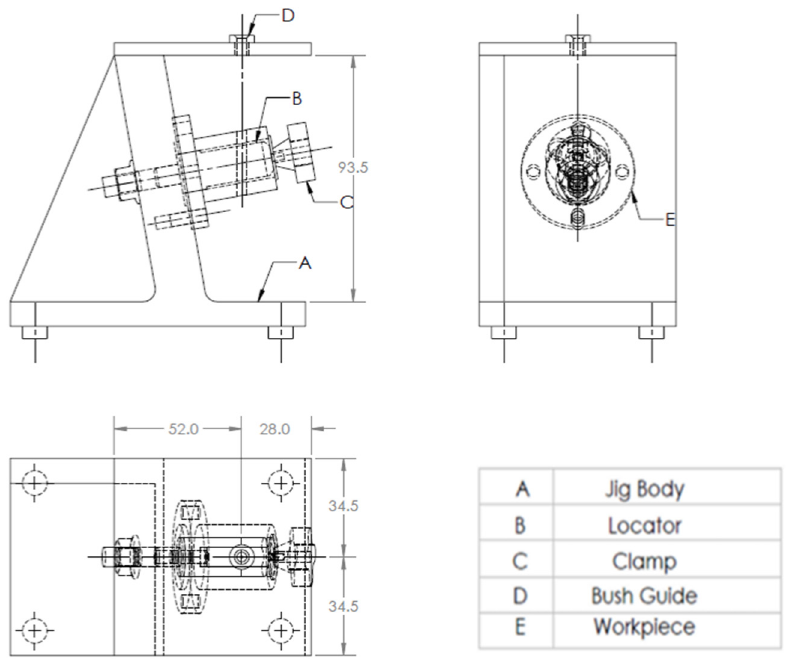
Figure 49. The drawing and isometric of the part.